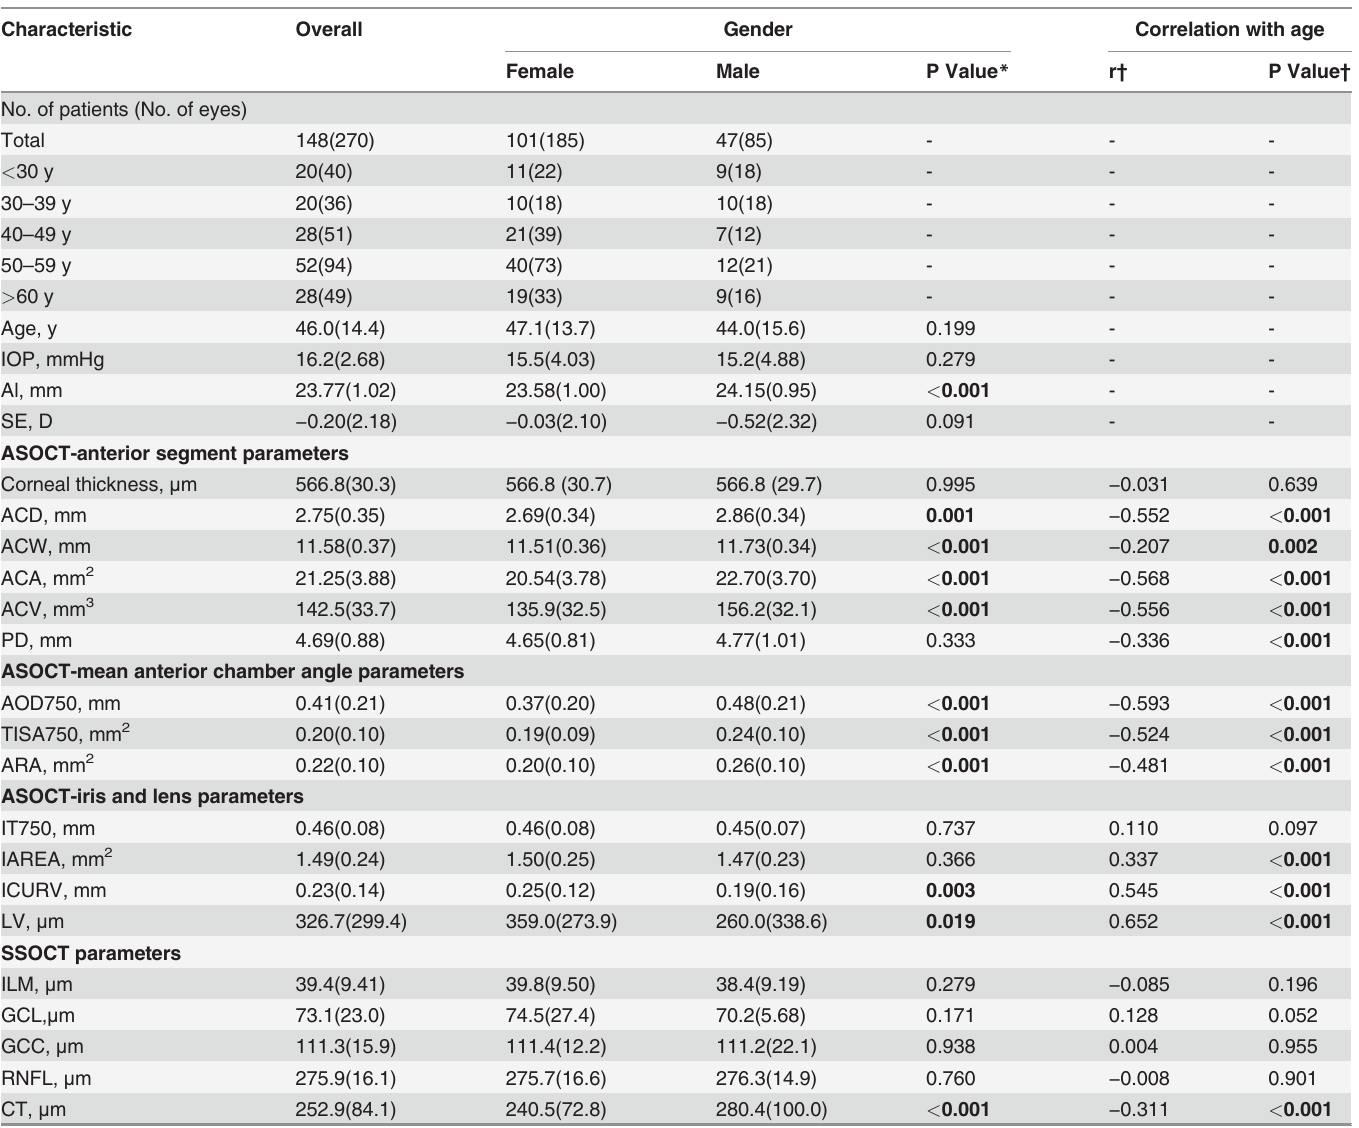
Table 1. Clinical characteristics of the study